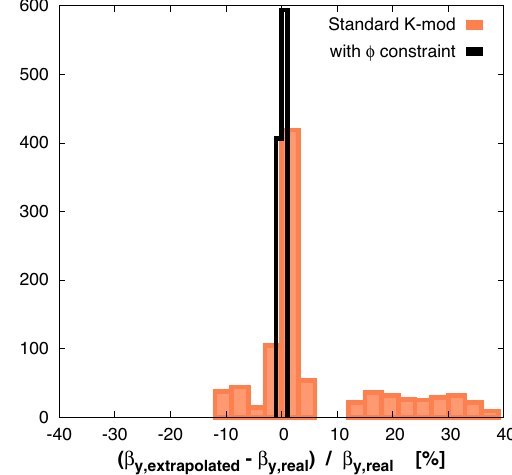
FIG. 14. Histograms of the percentage error on the β y at the location of the PS booster wirescanner, as determined in simulation via extrapolation from the nearest quadrupoles. Results are shown for 1000 test cases of the PS booster model encompassing the operational range of working points. Results are shown for the standard K-mod extrapolation method via minimization of Eq. (5) (orange) and for the K-mod extrapolation including the phase constraint, Eq. (10), with Ω ¼ 0 . 3 (black).